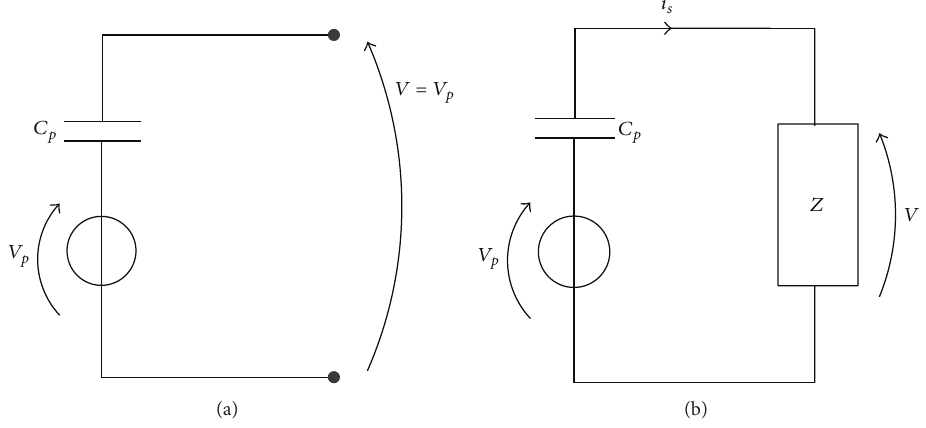
Figure 1: Electric equivalent of a piezoelectric actuator in open circuit (a) and shunted with impedance Z (b).